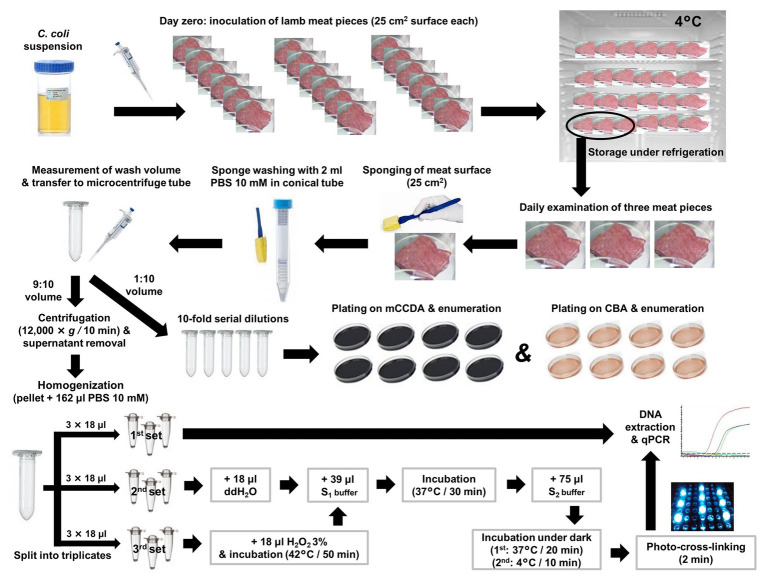
General experimental scheme for the quantification of culturable, total, and viable C. coli cells on artificially inoculated lamb meat pieces using plate counting, qPCR (control) and PMA-qPCR, respectively. S1 buffer: 10 mM Phosphate Buffer Saline (PBS; pH 7.0); 0.5 M Sucrose; 1.0 mg/ml Lysozyme; 50 mM EDTA. S2 buffer: 10 mM PBS (pH 7.0); 50 mM EDTA; 100 μM PMA. ddH2O: double-distilled water.